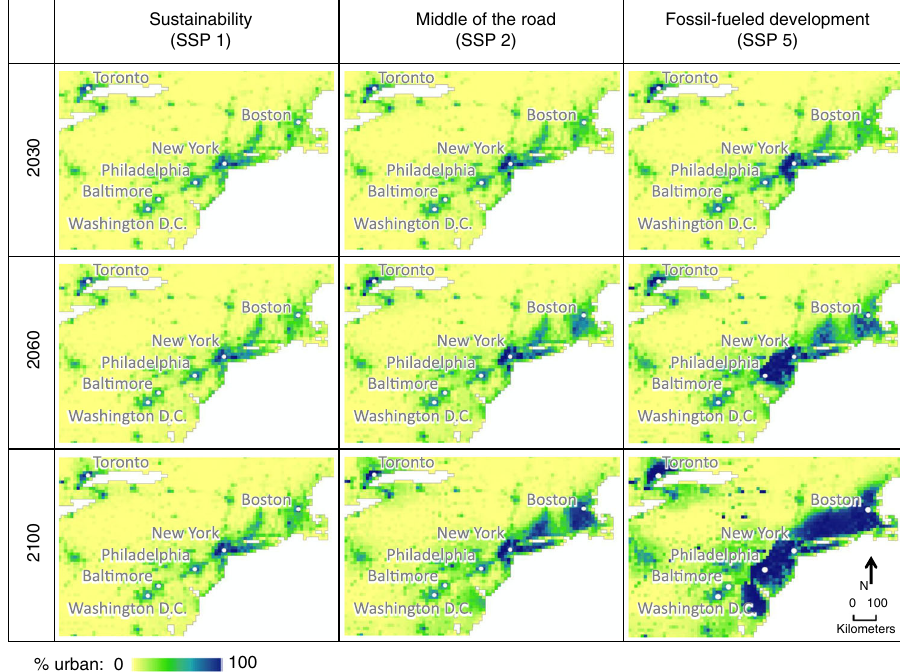
Fig. 5 Temporal pathways of urban expansion in northeastern United States under different scenarios. These maps show how different spatial patterns evolve under various scenarios through different pathways. Spatial patterns can differ, even when the overall amount of urban land in the displayed region is similar, e.g., SSP 2 in 2100 and SSP 5 in